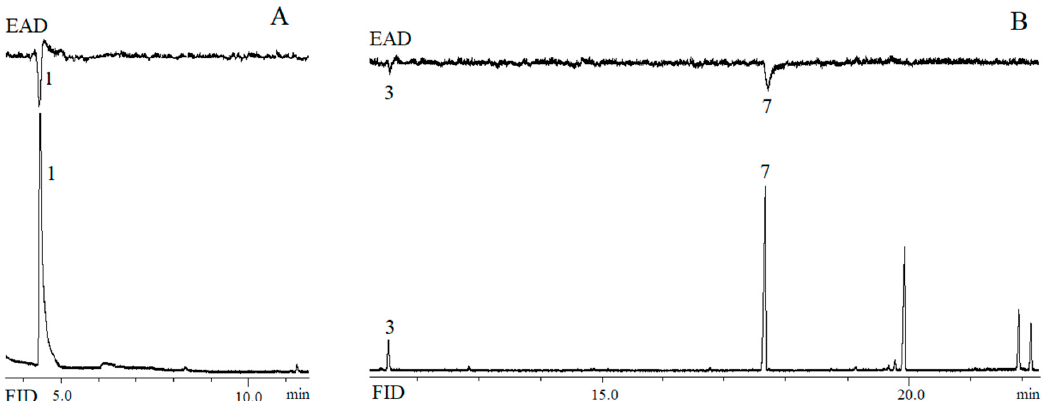
Figure 3. Simultaneous response of flame ionisation detector (FID) and electroantennographic detection (EAD) using B. musae ( A ) female antenna with rectal gland extract from conspecific males and ( B ) male antenna to rectal gland extract from conspecific females. Numbered peaks indicate EAD-active compounds: ethyl butanoate ( 1 ), ( E , E )-2,8-dimethyl-1,7-dioxaspiro[5.5]undecane ( 3 ) and ethyl laurate ( 7 ).